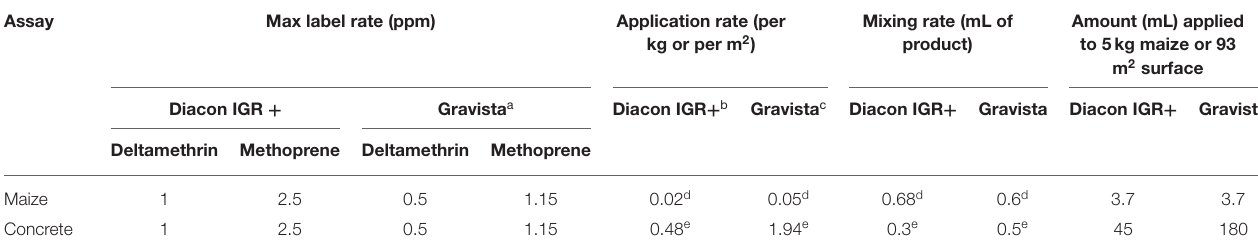
TABLE 1 | Summary of label, mixing, and application rates for insecticides used in residual assay.